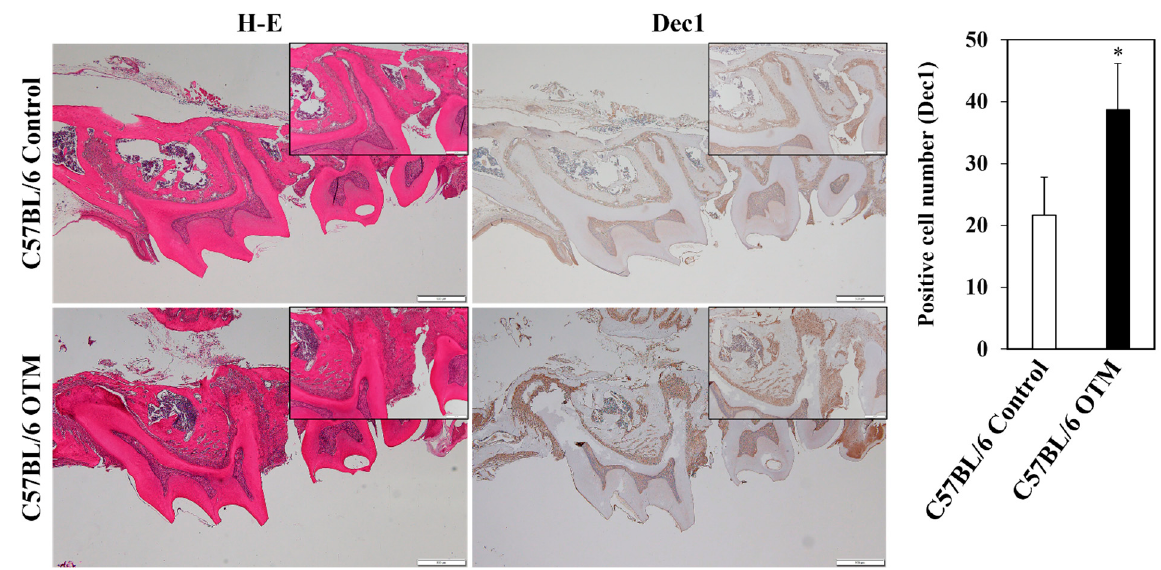
Figure 6. Dec1 is induced in the OTM of WT mouse tissues. Immunohistochemical staining revealed a higher expression of Dec1 in WT OTM mice compared to the control. Scale bars = 500 μ m. All results are representative of at least three independent experiments. The data shown represent means ± SD; * p < 0.05.